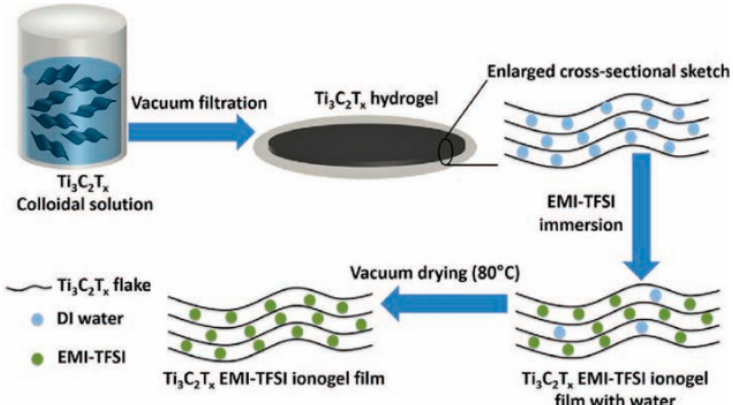
Figure 9. Schematic of the synthesis process of Ti 3 C 2 T x EMI-TFSI ionogel film. Reprinted with permission from [109]. Copyright 2016, Elsevier.